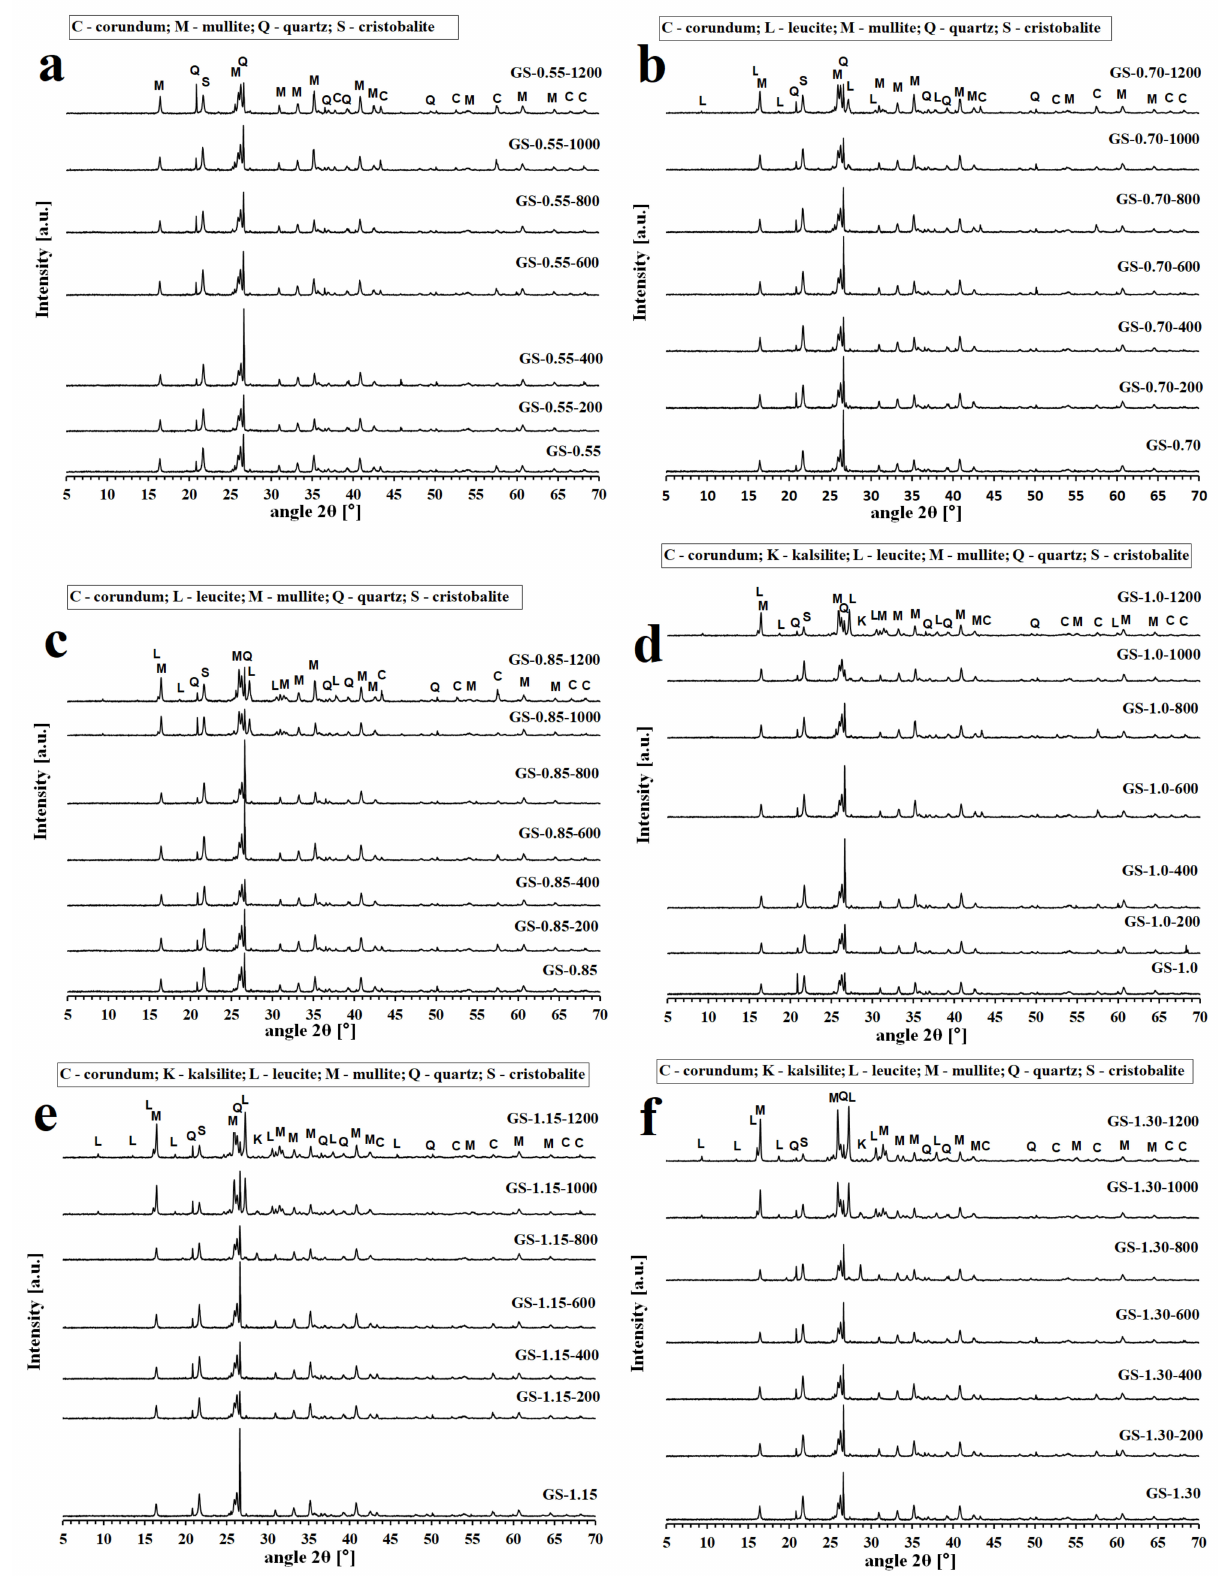
Figure 3. XRD patterns of the geopolymer composites with various molar ratios of K/Al (( a )—GS-0.55, ( b )—-0.70, ( c )—GS- 0.85, ( d )—GS-1.0, ( e )—GS-1.15, ( f )—GS-1.30) at laboratory temperature and after exposure up to 1200 ◦